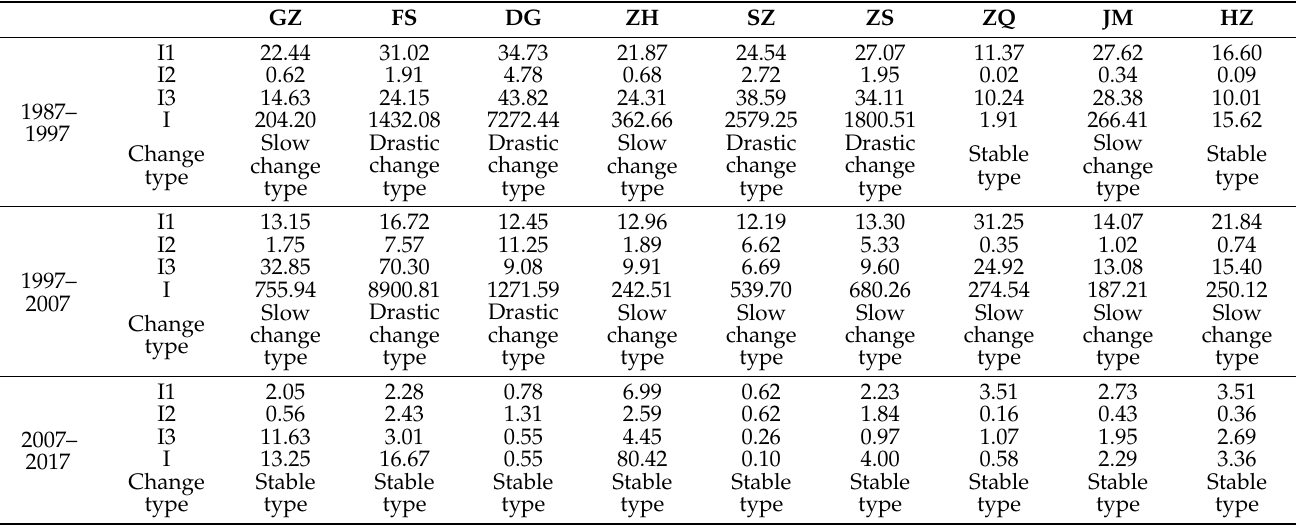
Table 3. Comprehensive change coefficient and change type of the manufacturing production space increments in the PRD in